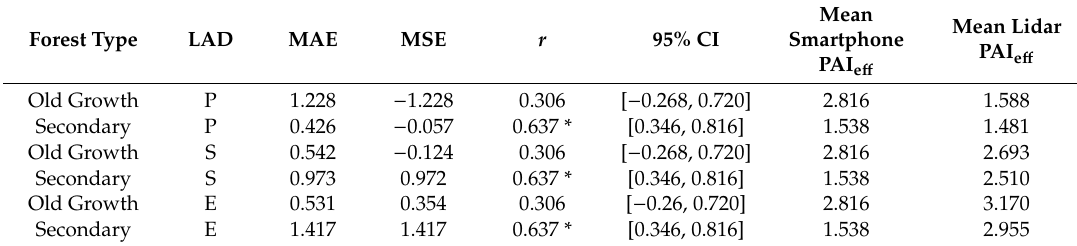
Table 2. Mean absolute error (MAE), mean signed error (MSE), Pearson’s correlation coe ffi cient ( r ), 95% confidence intervals (CI) for r and mean PAI e ff values comparing lidar and smartphone PAI e ff in subsets of old growth (n = 14) and secondary forest (n = 28) locations. Lidar PAI e ff was estimated using radius = 25 m and spherical (S), planophile (P) and erectophile (E) leaf angle distributions (LADs). * denotes statistically significant values ( p < 0.05).